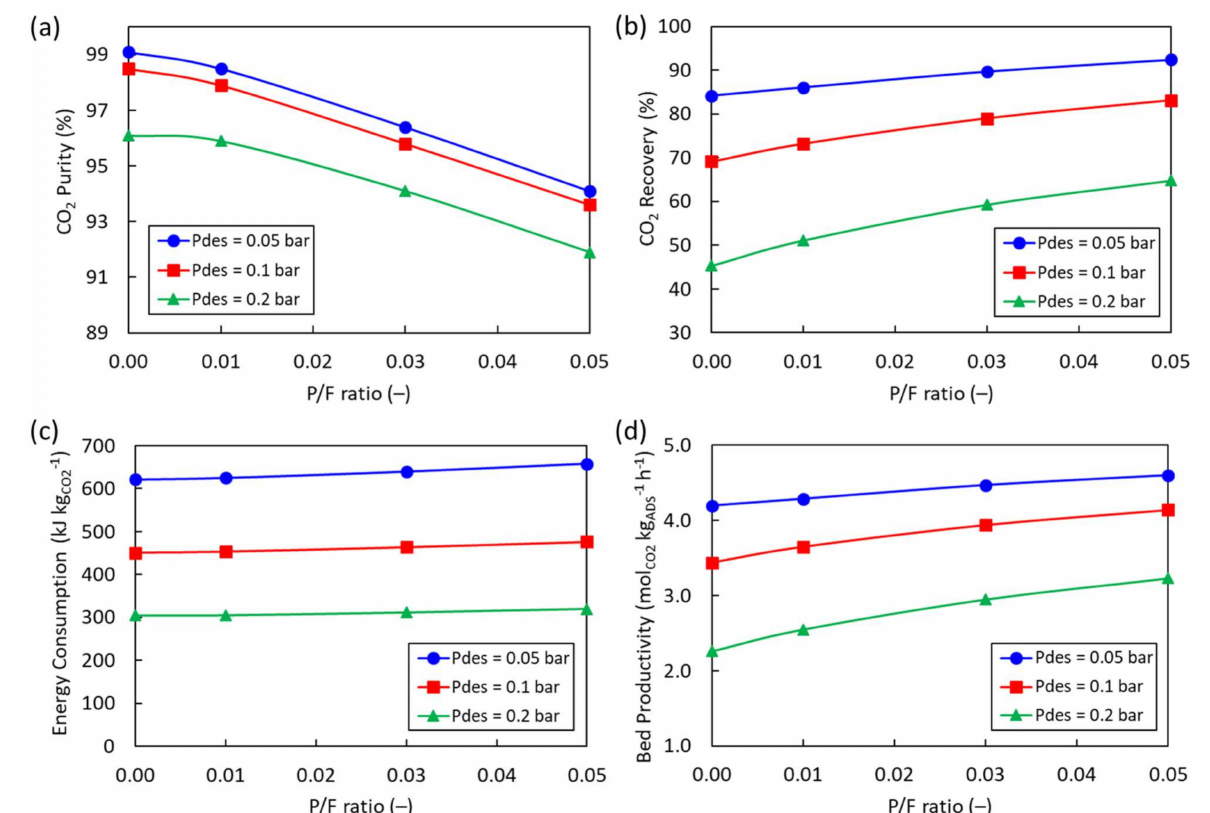
Figure 5. Evolution of the KPIs of the 2-bed, 6-step VPSA with the purge-to-feed ratio and desorption